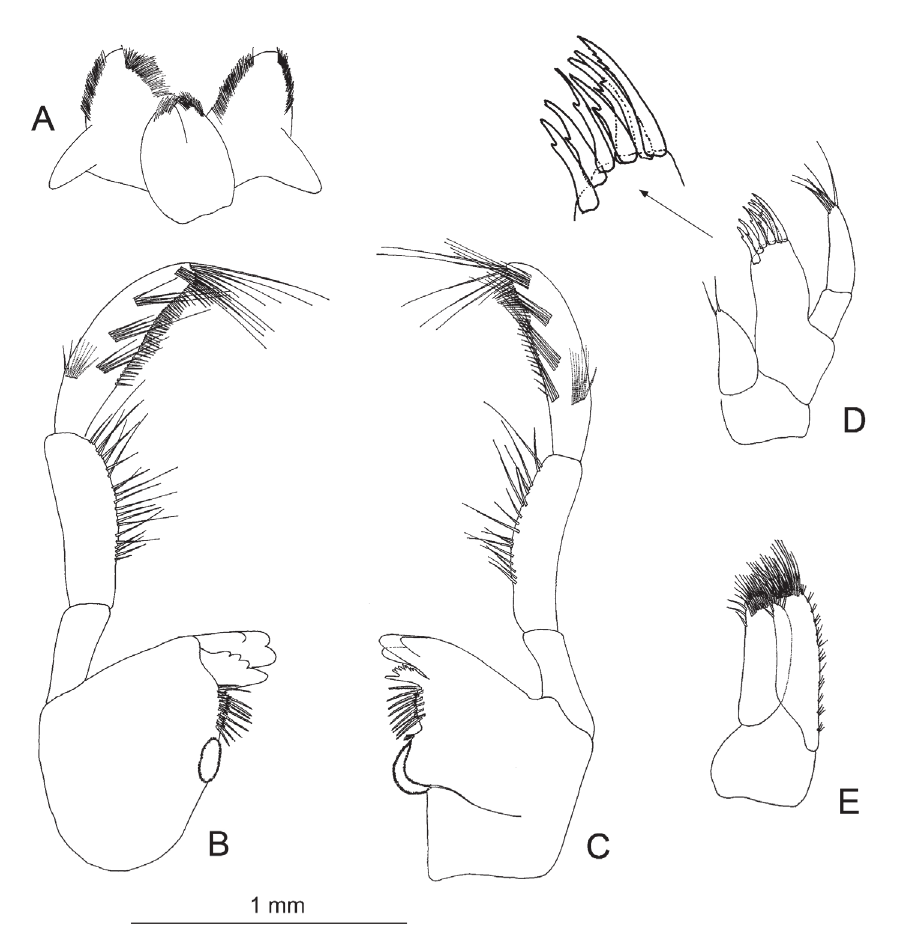
Figure 8. Niphargus enslini , male from the Blätterteighöhle A labium B left mandible C right mandible D maxilla I E maxila